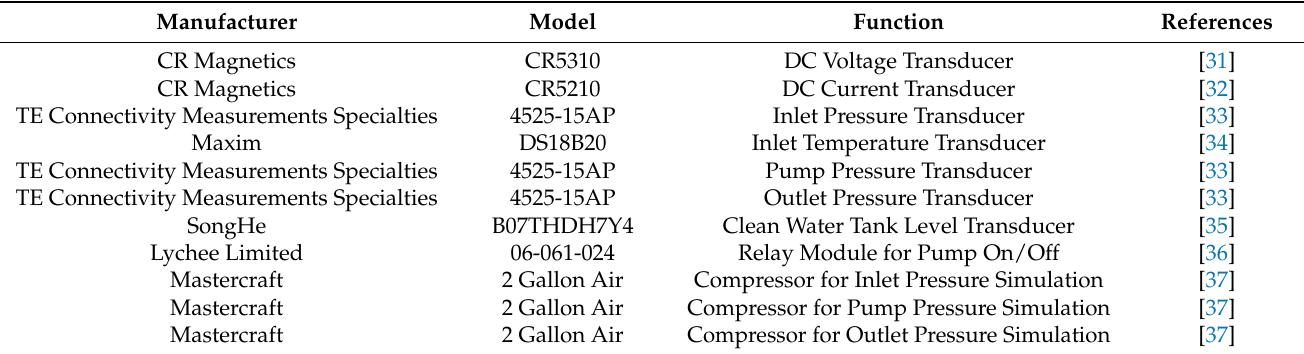
Table 1. Sensor manufacturer, models, and function.